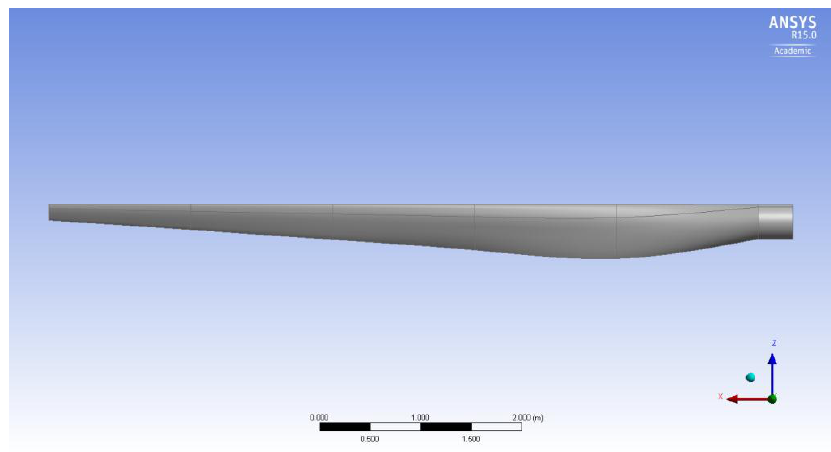
Figure 1. Numerical model of the blade.